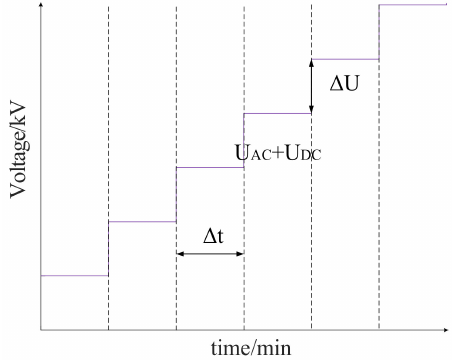
Figure 4. Voltage step-up